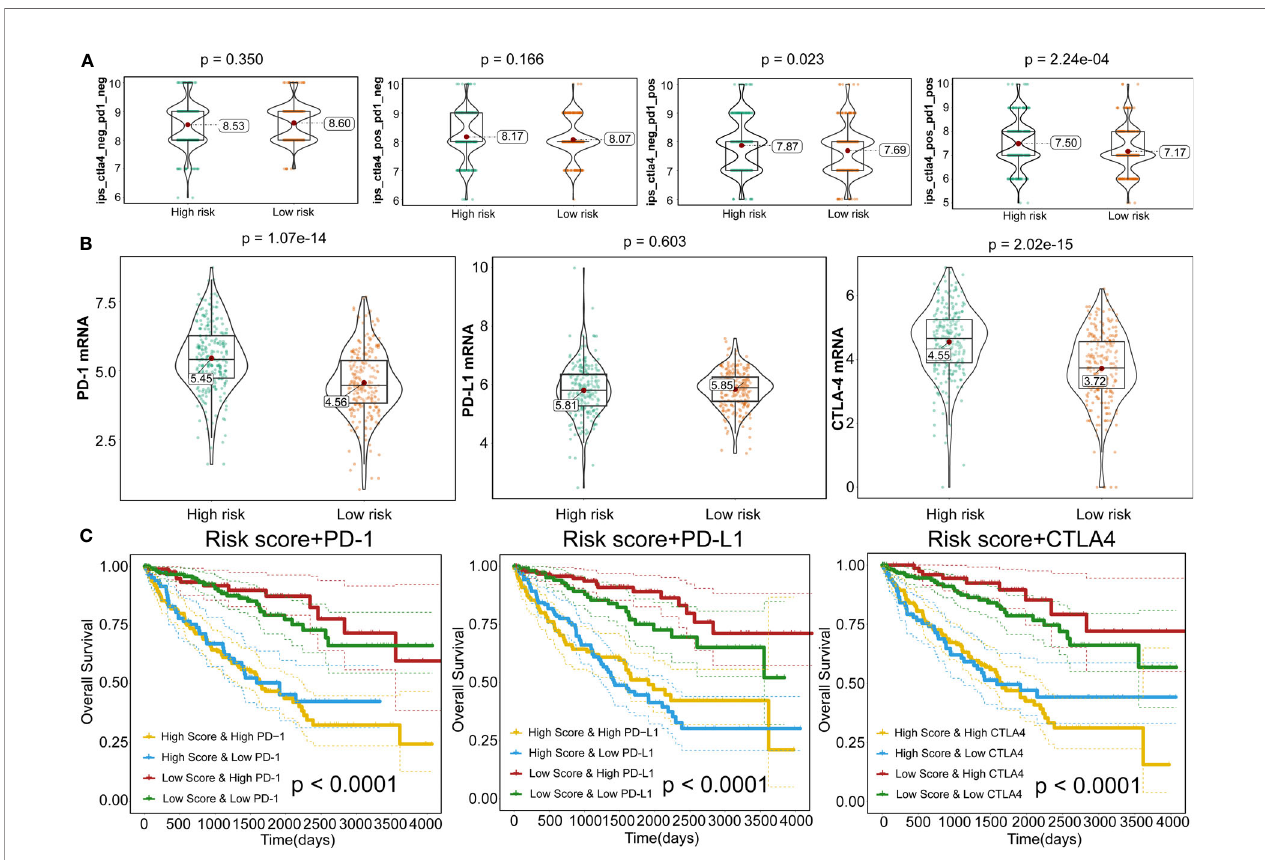
FIGURE 10 | Responses to immune checkpoint inhibitors. (A) Violin plots illustrate the relative probabilities for anti-PD-1 and anti-CTLA-4 treatment responses between high- and low-risk groups. (B) Violin plots for expression levels of PD-1, CTLA-4, and PD-L1 between high- and low-risk patients. (C) Kaplan – Meier curves for OS outcomes among four groups, according to risk score and PD-1, CTLA-4, and